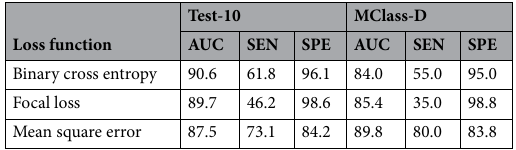
Table 1. Performance of original InceptionV3 of melanoma